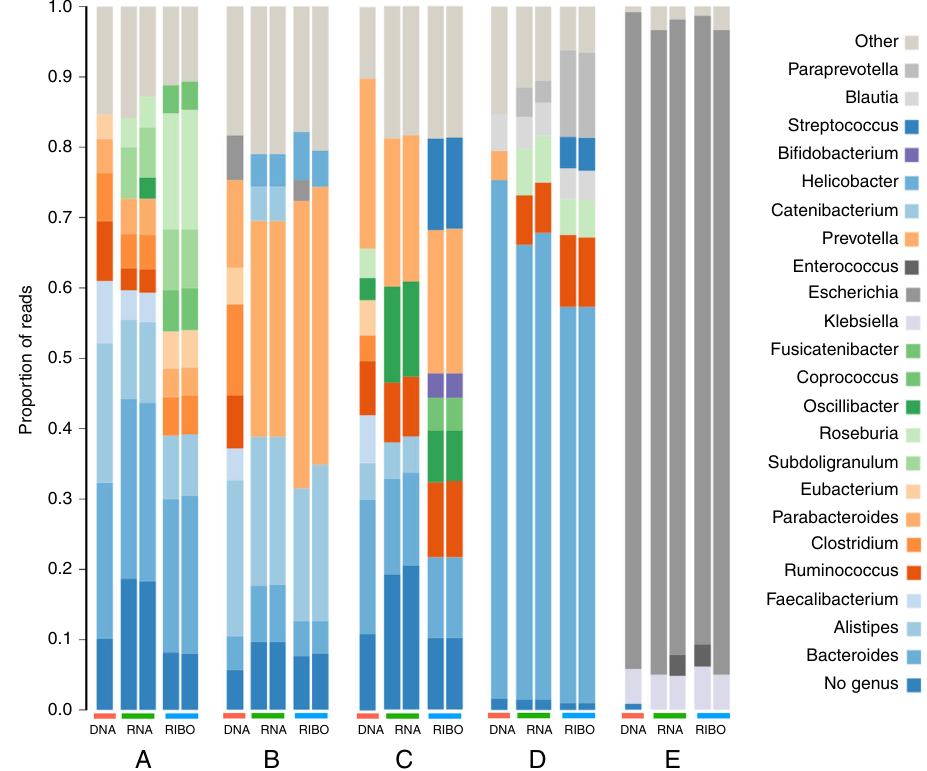
Fig. 3 Taxonomic composition of samples across sequencing technologies. Genus-level classi fi cations of all sequencing technologies performed on samples A – E. Replicates for metatranscriptomics and MetaRibo-Seq are shown for reproducibility. Only classi fi ed reads are shown. Taxa represented below 3% relative abundance are grouped into “ Other ” for visual